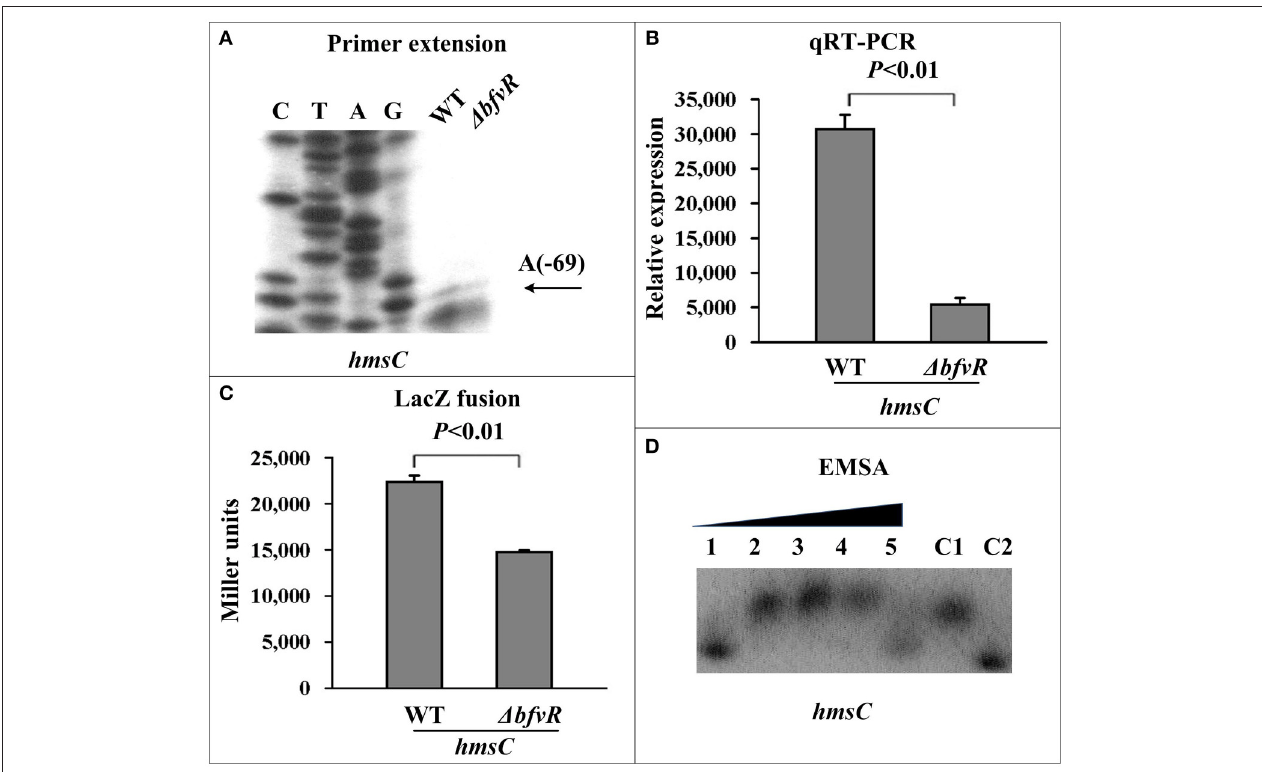
FIGURE 4 | Regulation of hmsC by BfvR. Reference to Figure 2 for the annotations of primer extension (A) , quantitative RT-PCR (B) , LacZ fusion (C) , and EMSA (D) . The promoter-proximal region from − 456 to + 55 was